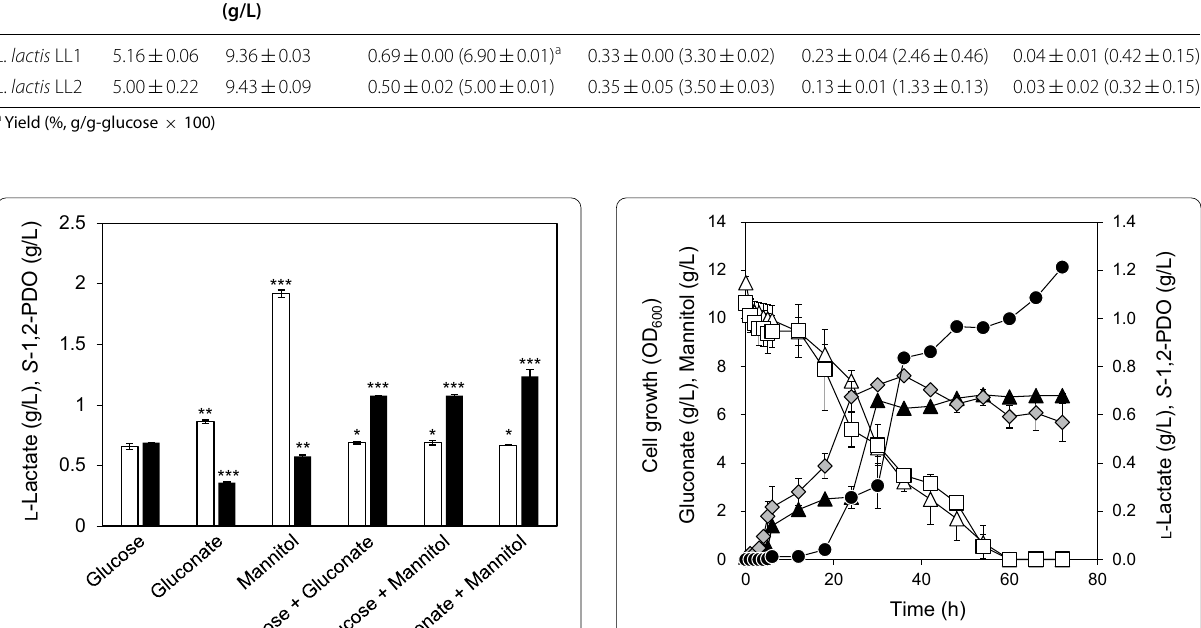
Time (h) Fig. 4 Production of 1,2-PDO in L. lactis LL1 with 1% gluconate and 1% mannitol in flask cultivation. L. lactis LL1 was cultivated for 72 h at 30 °C in M17 medium supplemented with 1% mannitol and 1% gluconate under microaerobic conditions. The medium was supplemented with 0.3 g/L acetate. The initial pH of the culture was 7.0. The culture was supplemented with 1 M MOPS (pH 7.0) every 24 h so that the pH of the culture was readjusted to 7.0. Closed triangles, cell growth (OD 600 ); closed circles, S -1,2-PDO; shaded diamonds, L-lactate; open triangles, mannitol; open squares, gluconate. This experiment was performed in duplicate, and the average is represented with error